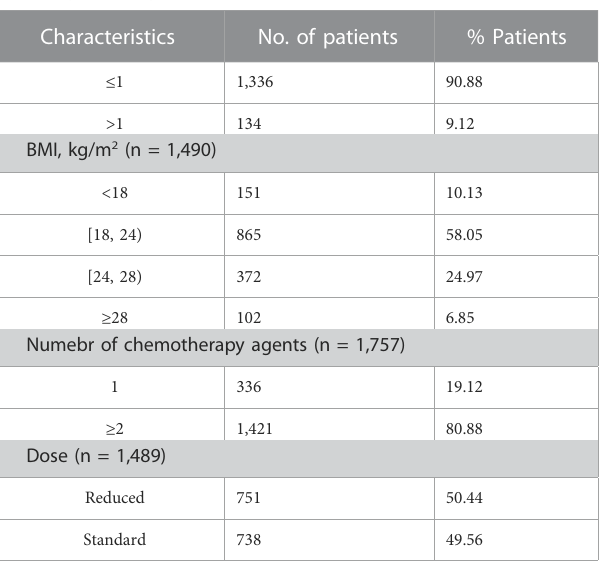
TABLE 1 Patients